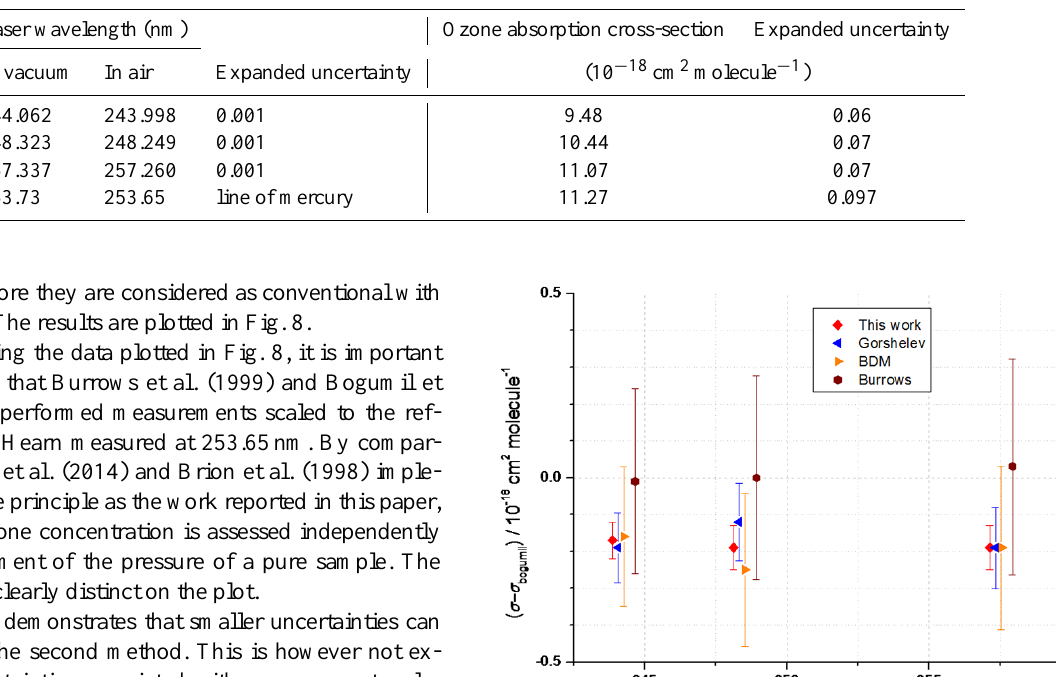
Table 3. Values of the ozone absorption cross-section at the three wavelengths of the argon-ion laser and their expanded uncertainties (coverage factor 95%).